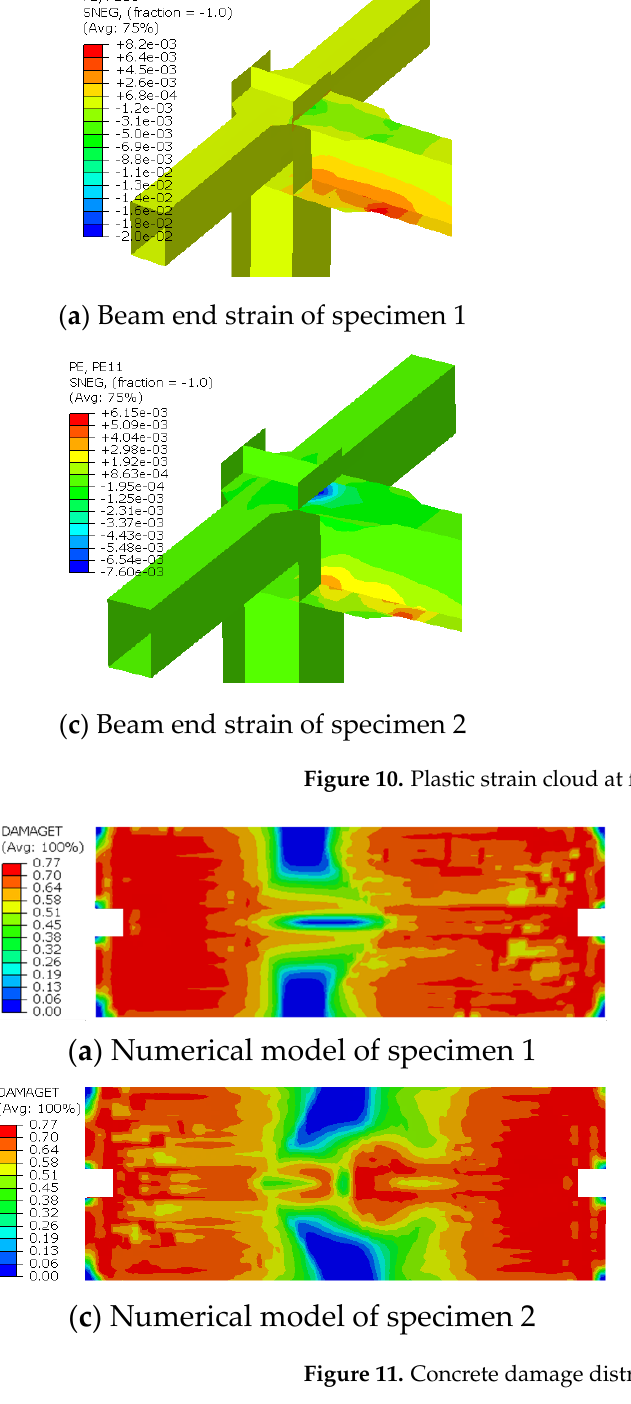
9001 20 0 Figure 12. Comparison of hysteresis loops. Table 2 compares the stress characteristic parameters of the skeleton curve obtained from the numerical model analysis to those obtained from the test skeleton curve. The error of both curves is less than 10%, indicating that the modeling method proposed in this study can accurately reflect the stress characteristics of the structural system, predict- ing the mechanical properties of the structure. - 1500 - 1200 - 900 - 600 - 3 0 00300 600